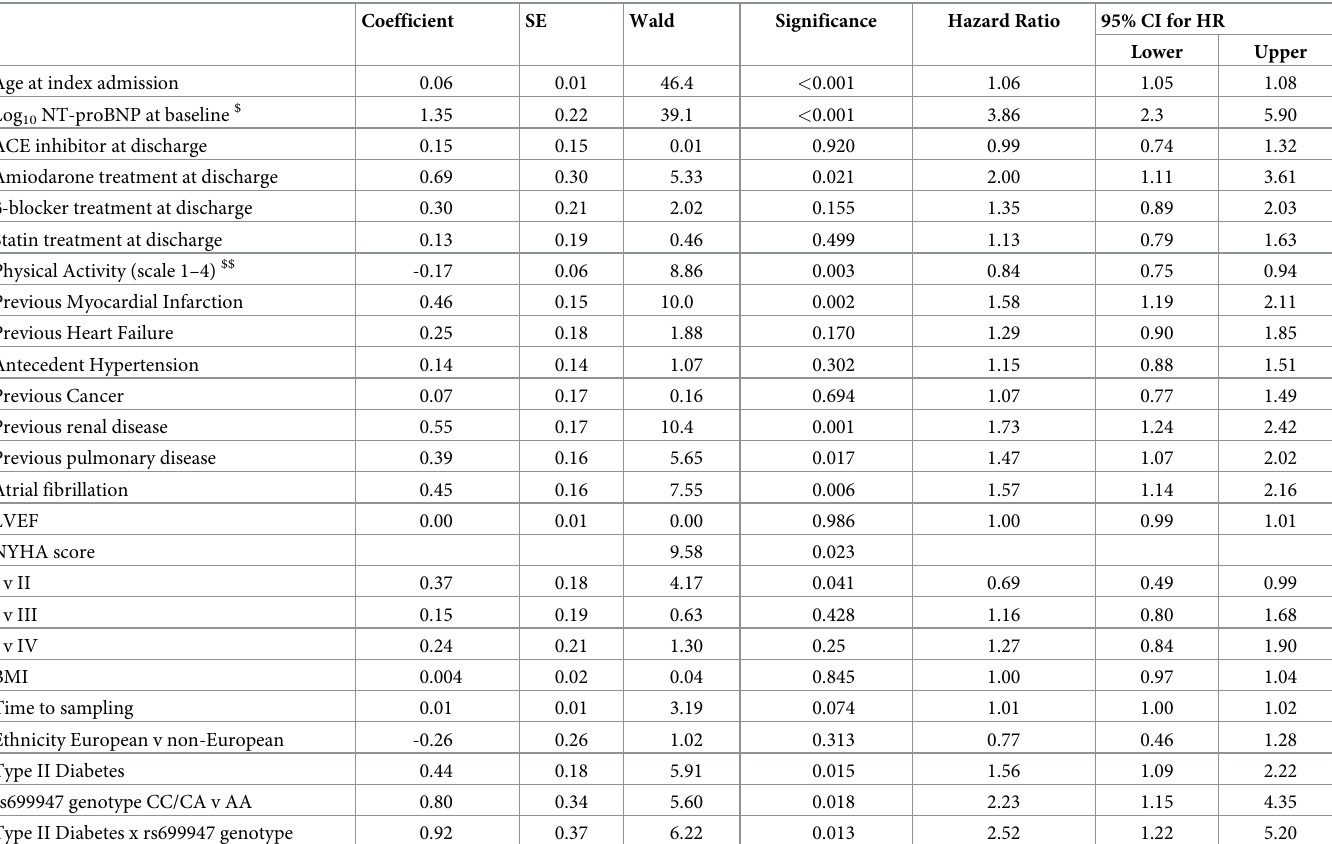
Table 4. Cox’s proportional hazards regression model for mortality in male patients from the CDCS cohort (n = 1215, 249